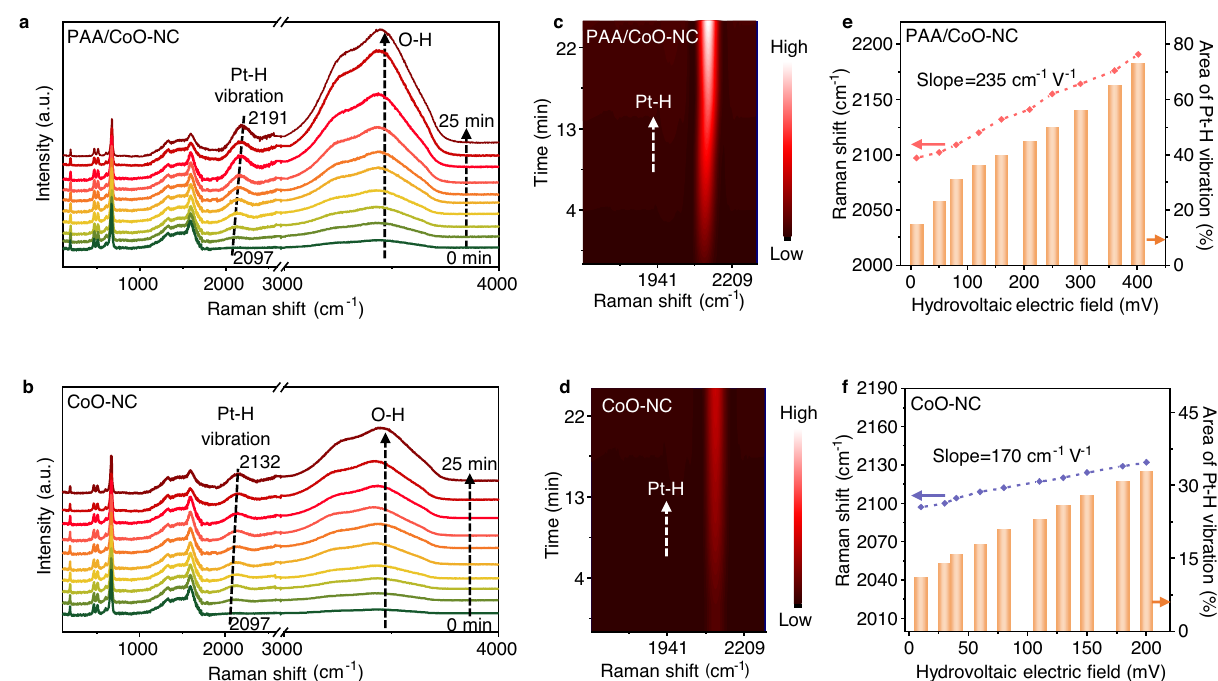
Fig. 4 | The kinetics of water splitting reaction of the hydrovoltaic effect- enhanced photocatalysis system. a In situ Raman spectra of the PAA/CoO – NC surface over time with hydrovoltaic effect under light irradiation; b In situ Raman spectra of the CoO – NC surface over time with hydrovoltaic effect under light irradiation; c 2D contour maps of Pt – H vibrations on PAA/CoO – NC; d 2D contour maps of Pt – H vibrations on CoO – NC; e Raman shifts and area ratios of the Pt – H bond versus the hydrovoltaic potential range produced by the electric fi eld at the